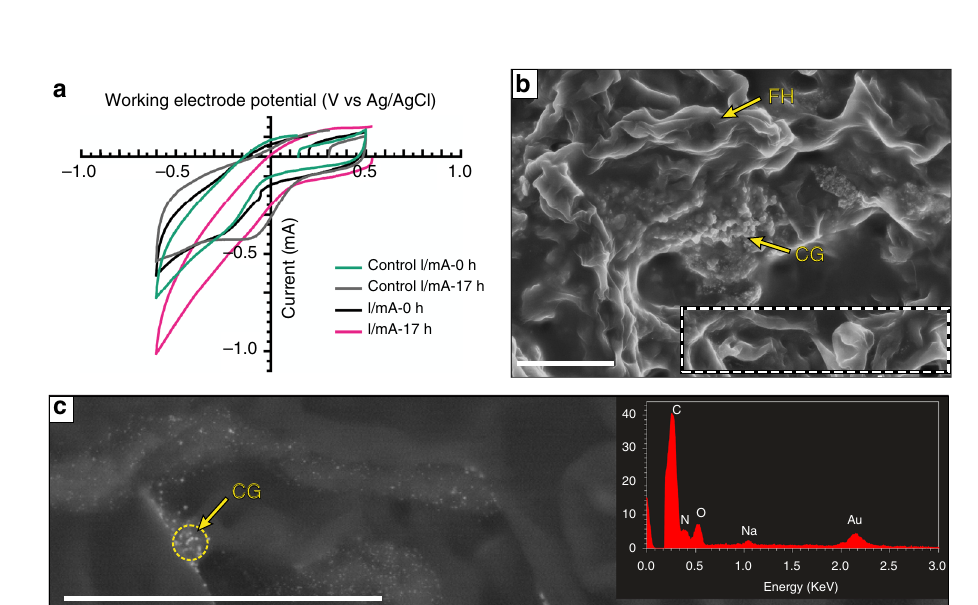
Fig. 4 Interaction between TA_pink1 and colloidal gold in liquid media. a Cyclic voltammograms of TA_pink1 after 0 and 17 h of incubation in the presence and absence of colloidal gold. Control, TA_pink1 incubated without colloidal gold. b Scanning electron micrographs of colloidal gold (CG) with the fungal hyphae (FH) of TA_pink1in liquid PYG medium after 14 days of incubation at 10 °C. Scale bar, 5 µ m. c Detailed view of nanometer gold particles and surrounding materials (yellow arrows) over the surface of fungal hyphae. Scale bar, 5 µ m. The inset shows an EDS pro fi le of the major components of the phase (79.9 h), although the patterns of the two extension curves Fig. 4b, Supplementary Table 3). Pleosporales and Capnodiales were nearly identical.